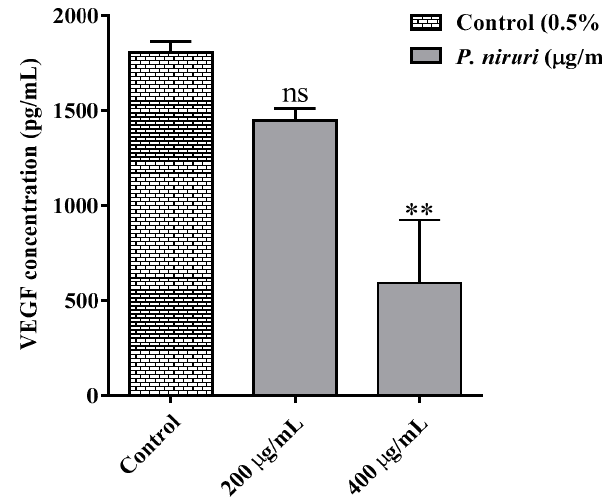
Figure 8. Effects of 50%ME of P. niruri on vascular endothelial growth factor (VEGF) concentration compared with the control (DMSO) according to ELISA examination kit. All values are expressed as mean ± SEM, ** p < 0.01 vs. the control (DMSO).